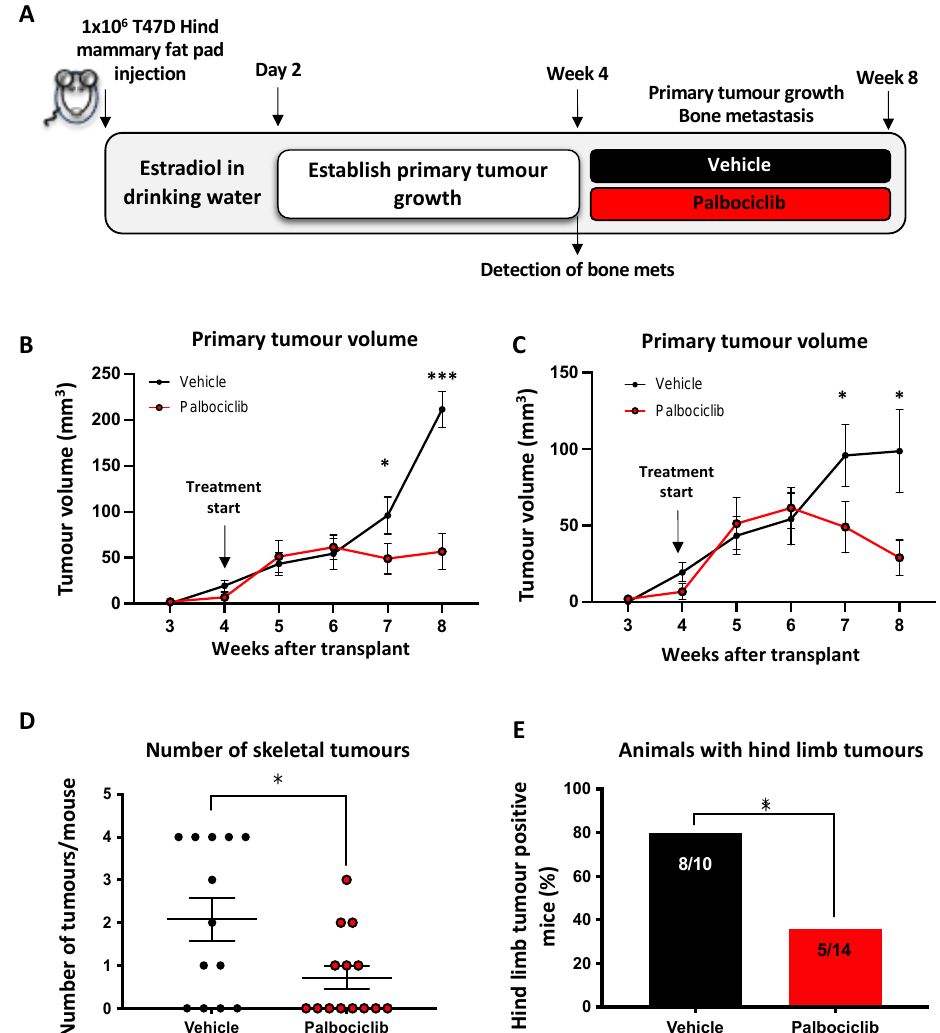
Figure 2. Palbociclib treatment inhibits primary tumour growth and bone metastasis in ER+ BC. ( A ) Generation of ER+ BC model of metastasis. The group of 14-week-old BALB/c nude mice were supplemented with estradiol in the drinking water. Two days later, 1 × 10 6 T47D(luc2+GFP+) ER+ cells were injected bilaterally into the hind mammary fat pad. An amount of 100 mg/kg palbociclib was administered 4 weeks after tumour cell injection and continued for a further 4 weeks. ( B ) Primary tumour volume in vehicle treated animals compared to palbociclib from our initial experiment ( n = 7 per group, mean ± SEM, * p < 0.05, *** p < 0.0005). ( C ) Primary tumour volumes from two experiments combined (vehicle ( n = 14) vs. palbociclib ( n = 14) mean ± SEM, * p < 0.05). ( D ) The number of skeletal tumours after four weeks of treatment in the two studies combined (mean ± SEM n = 13 per group * p < 0.05). ( E ) The proportion of mice exhibiting skeletal tumours in response to palbociclib after four weeks of treatment in the two studies (mean ± SEM, * p < 0.05).